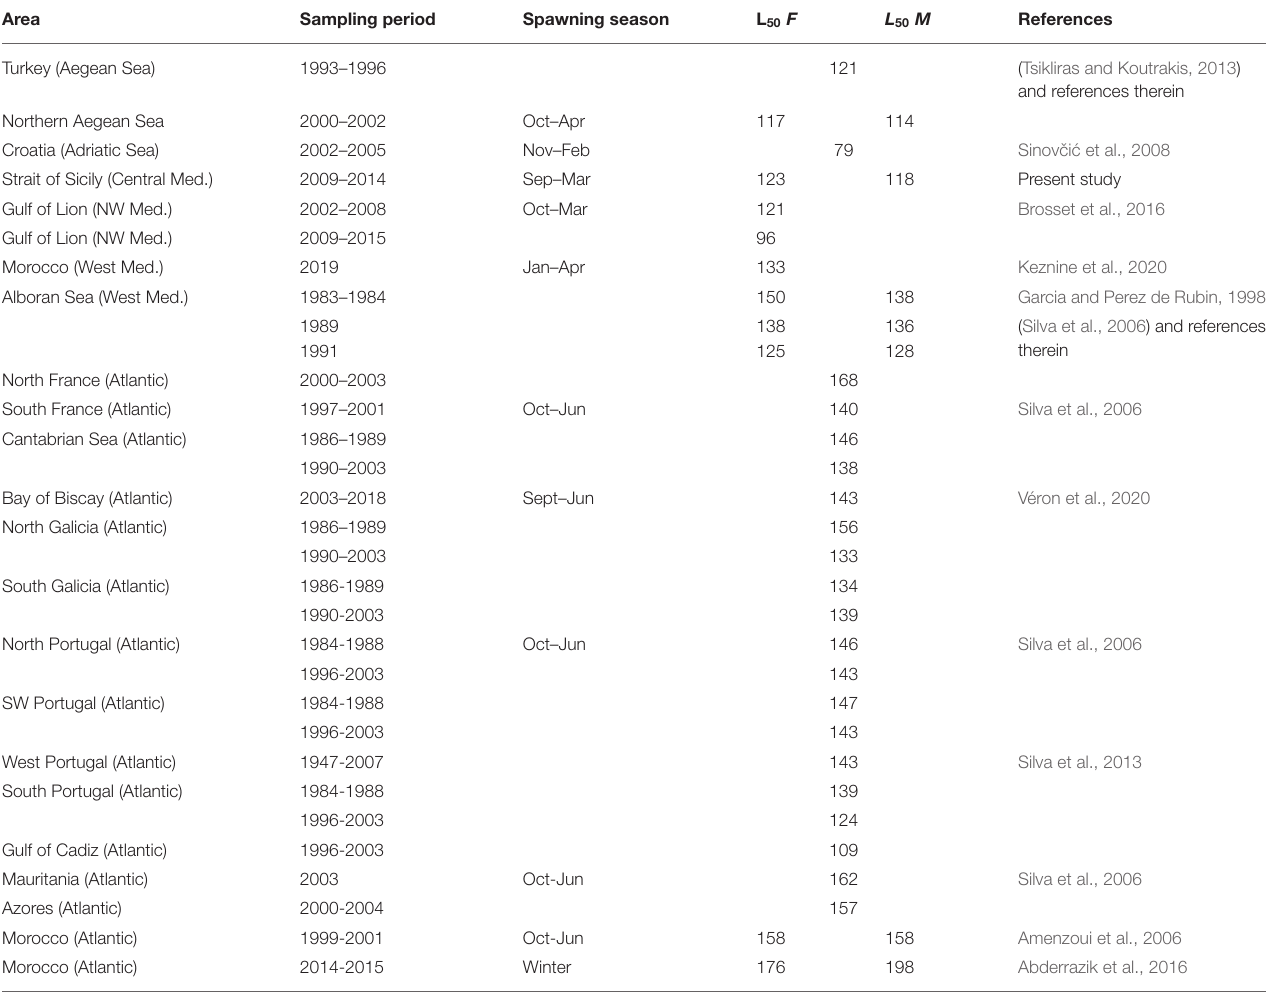
TABLE 3 | Literature values of size at maturity of European sardine estimated in the Mediterranean Sea and Atlantic